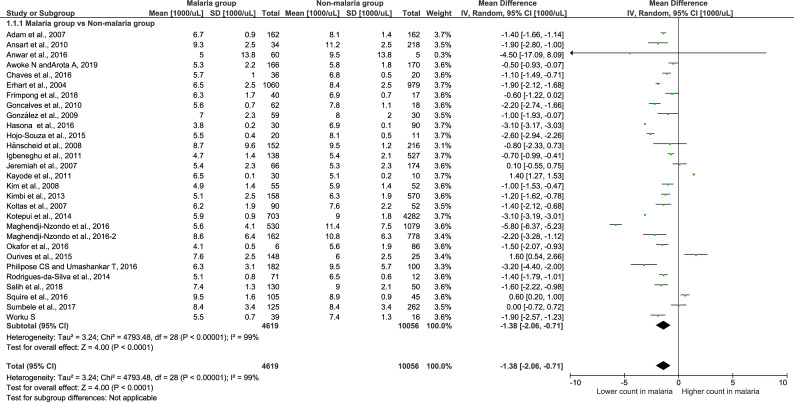
Forest plot of the total leukocyte count among included studies.Forest plot showing the total leukocyte count in the malaria and non-malaria groups. [1000/μL] refers to 1000 per microliter; “IV" in "IV, Random” refers to Inverse variance; "Total" in top row refers to number of patients included; A green square in the horizontal line refers to the mean difference for each of included study.